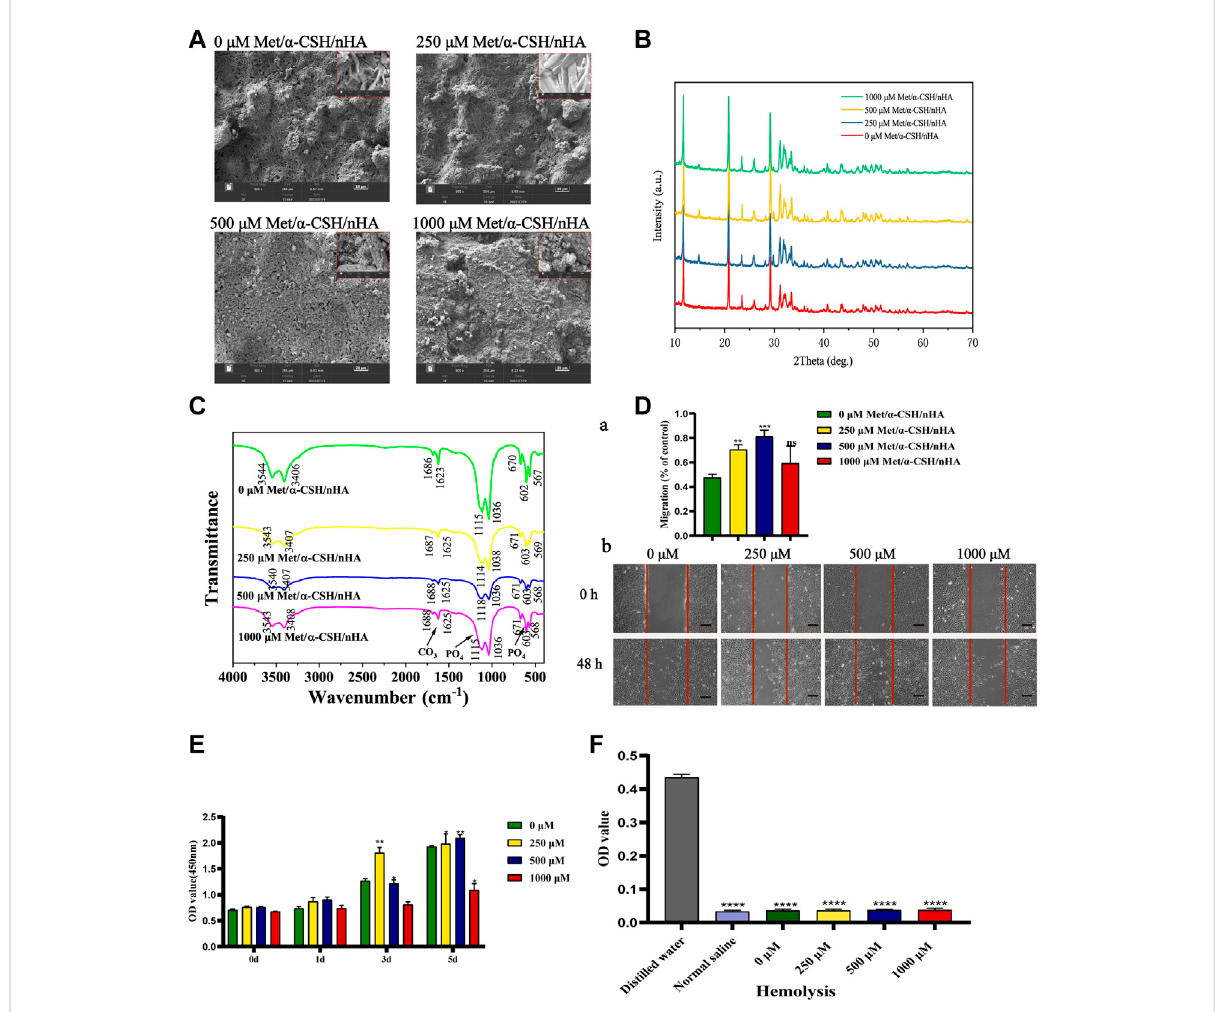
FIGURE 1 Characterization of Met/ α -CSH/nHA prepared with different metformin concentrations (0, 250, 500, and 1,000 μ M). SEM (A) (Scale bar = 20 μ m), XRD (B) , FTIR (C) demonstrate that metformin is physically bound to α -CSH and nHA and can be stably present. Cell scratch assay (D) demonstrates that the material containing 500 μ M of metformin is more capable of promoting cell migration (Scale bar = 200 μ m); CCK8 (E) and haemolysis assay (F) show that all groups of materials are more biocompatible and less likely to cause tissue